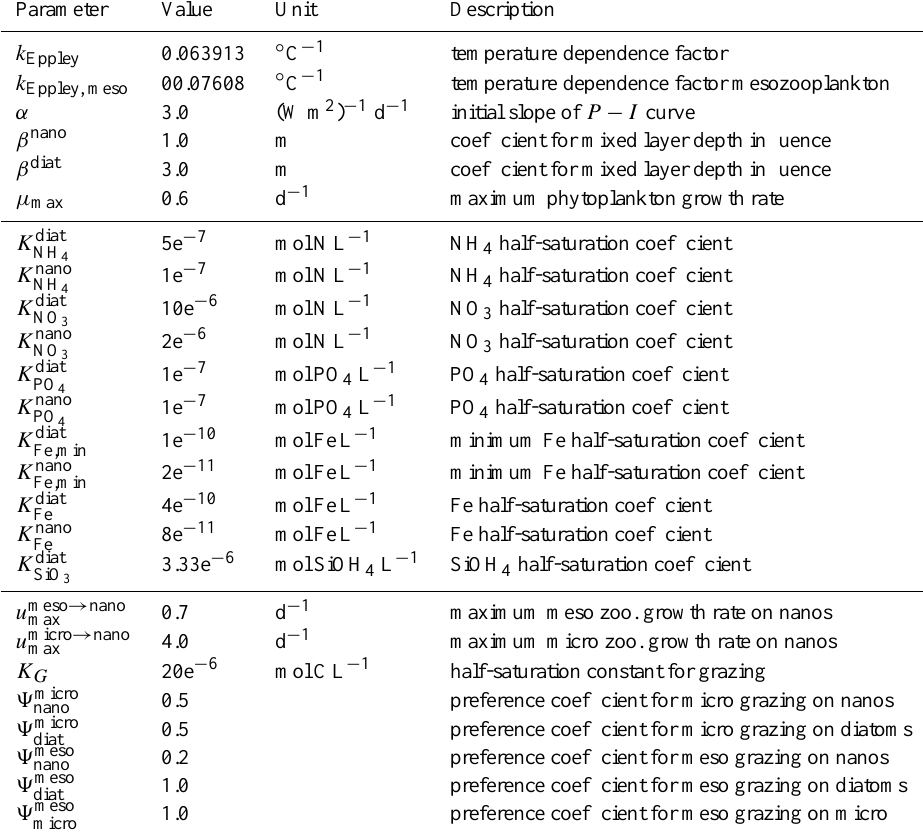
Table A4. PISCES